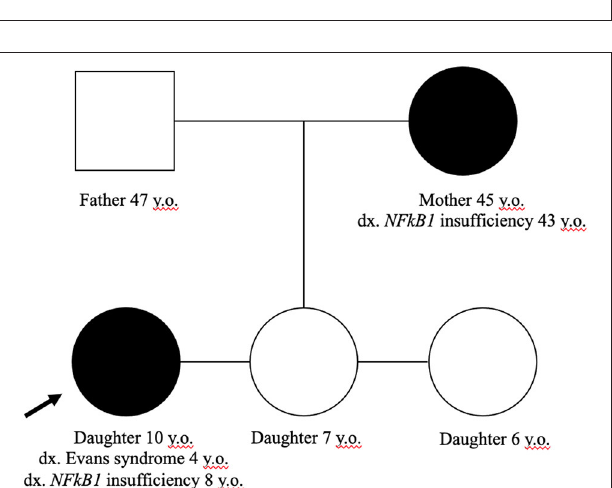
FIGURE 1 | Timeline of clinical events for patient and patient’s daughter.